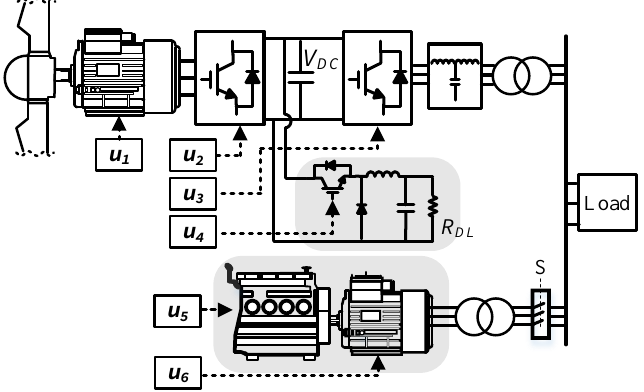
Figure 3. Components and control signals of the stand-alone system.